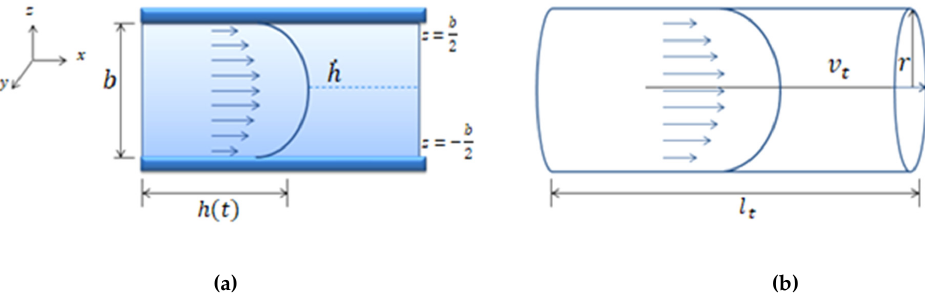
Figure A1. ( a ) Schematic representation of a Poiseuille flow between two parallel walls separated at a distance b. The mean front velocity, h(cid:4662) , and the flow inside the microfluidic channel is (cid:3435)Q = h(cid:4662)ωb(cid:3439) . ( b ) Schematic representation of Poiseuille flow in a cylindrical tube of radius r and length l (cid:2930) . The velocity, v (cid:2930) , is the mean velocity of the fluid inside the cylindrical tube and Q (cid:2930) is the flow inside the tube (Q (cid:2930) = πr (cid:2870) v (cid:2930) ).